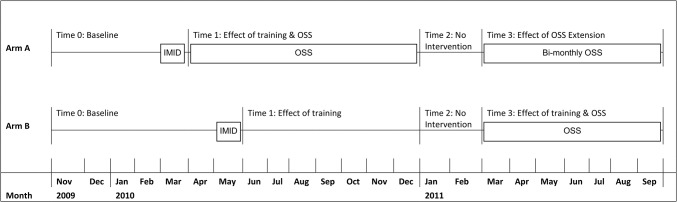
Evaluation Design.